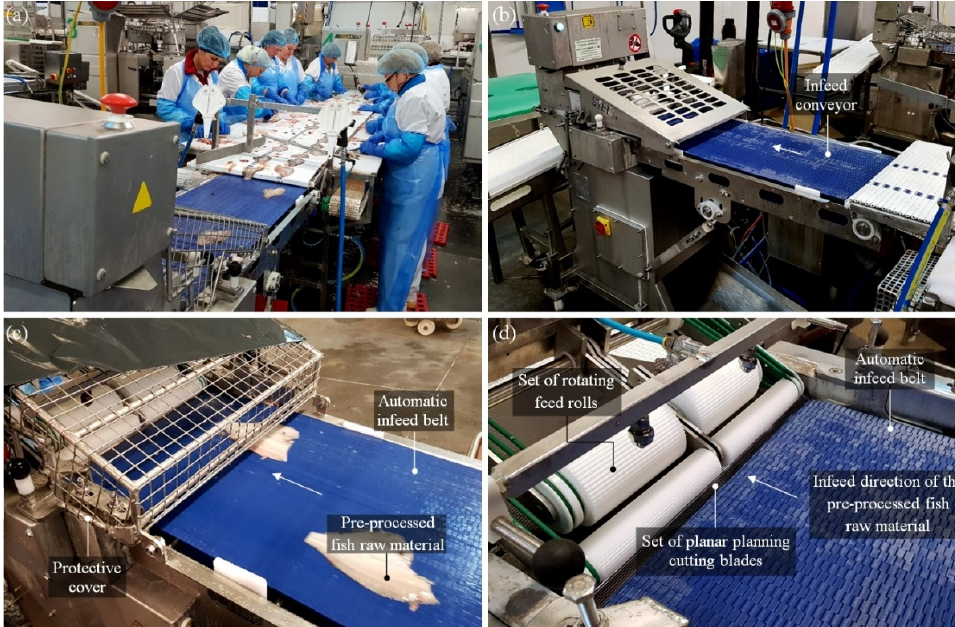
Figure 1. Overview of the skinning process of flat fishes from the Pleuronectidae family: ( a ) general view of technological line; ( b ) general view of automatic skinning machine ST600 (Steen F.P.M. International, Kalmthout, Belgium); ( c ) conveyor belt with pre-processed raw fish material; ( d ) mounting position of planar industrial cutting blades.